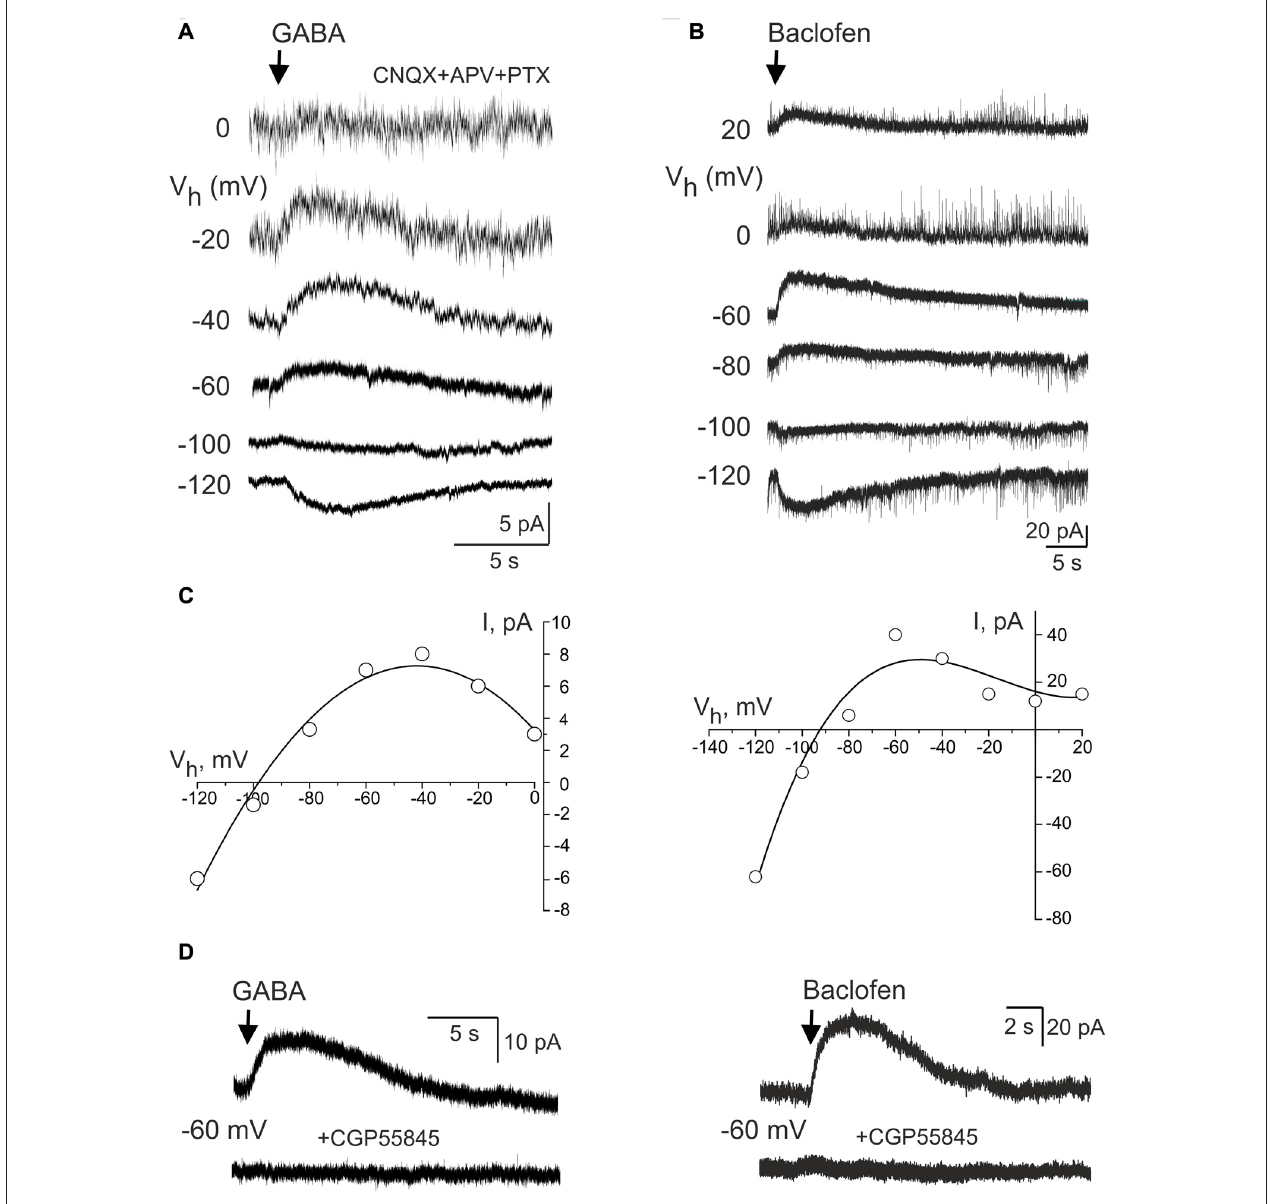
FIGURE 6 | GABA(B) receptor activated currents in CA3 pyramidal cells. (A,B) Whole-cell voltage-clamp recordings of the currents evoked by brief local application of GABA in the presence of the glutamate and GABA(A) receptor antagonists (A) and GABA(B) receptor agonist baclofen (B) at different holding potentials. (C) Corresponding current-voltage relationships of the GABA(B) receptor activated currents. Note a reversal near the potassium equilibrium and an inward rectification. (D) The effect of the selective GABA(B) receptor antagonist CGP55845 on the responses evoked by GABA (left) and baclofen (right).